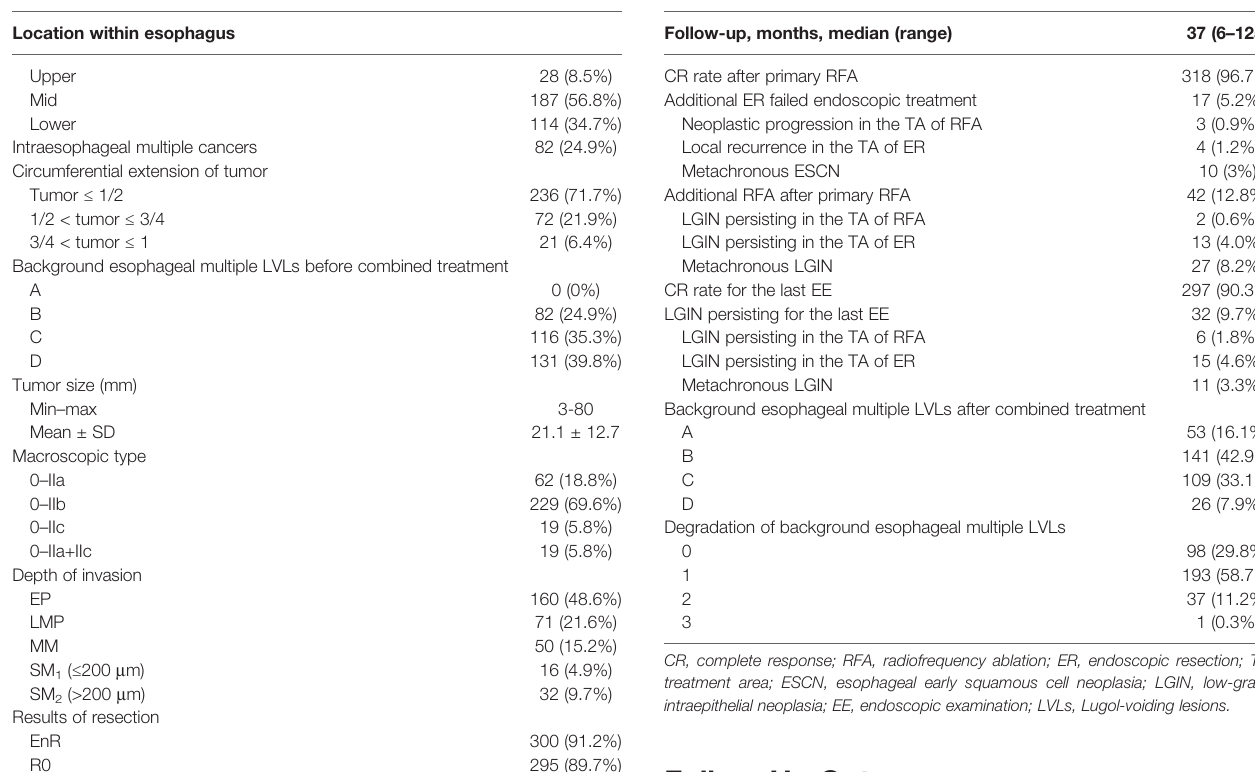
TABLE 3 | Clinical results of postoperative